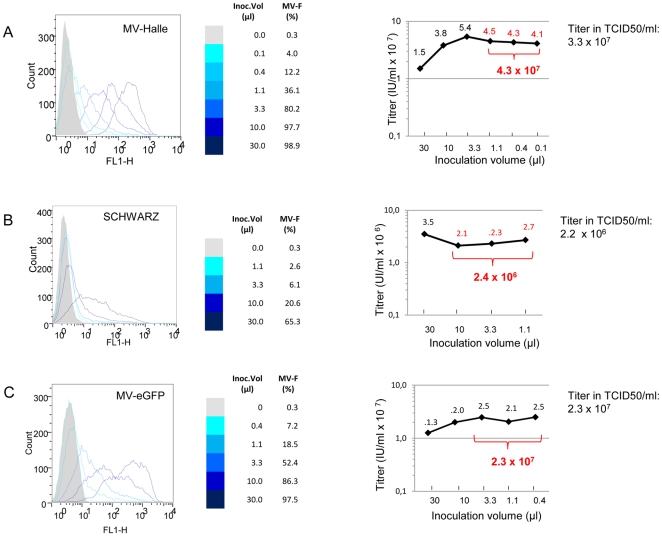
Titer calculation of different measles virus strains.
(A) Calculation of MV-Halle titer based on flow cytometry detection of MV-F protein. 3-fold serial dilutions of MV-Halle viral stock were used to infect Vero cells. The percentage of infected cells was determined at 18 h.p.i. by flow cytometry. As seen with the histogram, the peak of MV-F positive cells shifts towards the negative cells (left) gradually with the decrease in viral volume used (left panel). The titers expressed as infectious units per milliliter (IU/ml) were calculated for each inoculum size as a percentage of the uninfected cells, according to the Poisson Law (right panel). The values in red were used to calculate the average titer. (B) Calculation of MV-Schwarz titer based on flow cytometry detection of MV-F protein. 3-fold dilutions of MV-Schwarz viral stock were used to infect Vero cells. The percentage of infected cells was determined at 18 h.p.i. by flow cytometry (left panel). The titers expressed as infectious units per milliliter (IU/ml) were calculated for each inoculum size as a percentage of the uninfected cells, according to the Poisson's law (right panel). The values in red were used to calculate the average titer. (C) Calculation of MV-eGFP titer based on the detection of GFP positive cells by flow cytometry. 3-fold serial dilutions of MV-eGFP viral stock were used to infect Vero cells. The percentage of GFP expressing infected cells was determined at 18 h.p.i. by flow cytometry (left panel). The titers expressed as infectious units per milliliter (IU/ml) were calculated for each inoculum size as a percentage of the uninfected cells, according to the Poisson's law (right panel). The values in red were used to calculate the average titer.